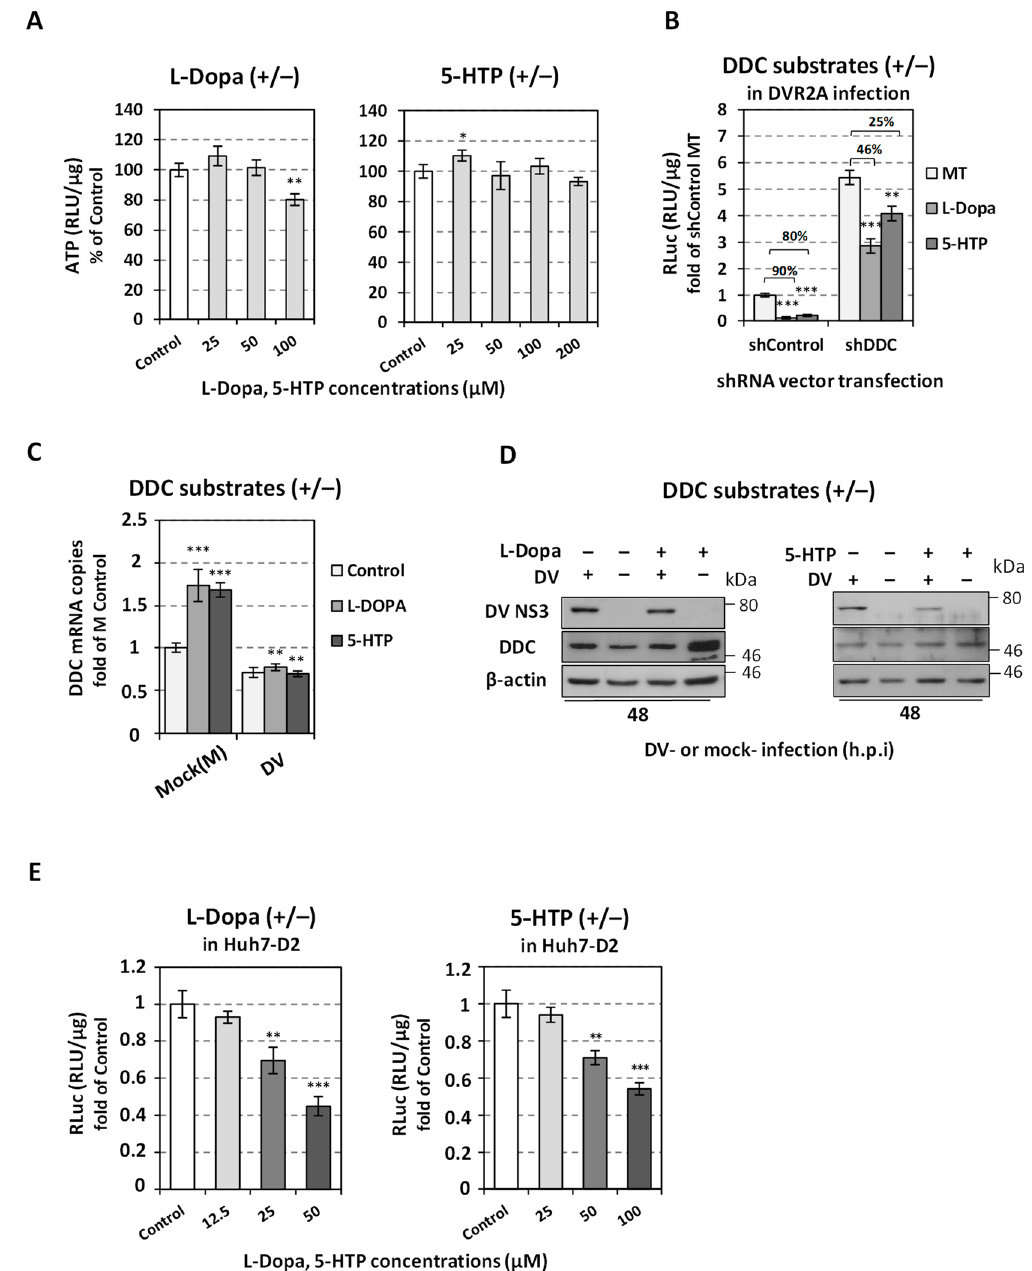
Figure 4. The application of DDC substrates negatively affects the replication of DV. ( A ) Evaluation of different concentrations of DDC substrates concerning their cytotoxicity of DV-infected cells. Huh7 cells were transfected with the shControl vector (via electroporation) and 24 h.p.t. were inoculated with DV (MOI = 0.1) for 4 h. After virus inoculum removal, cells were treated with different concentrations of L-Dopa (left panel) or 5-HTP (right panel), or were mock-treated (Control), for 48 h. Then the cells were lysed and by the use of a chemiluminescence-based assay, the intracellular ATP was quantified. Infected mock-treated cell (Control) values were expressed as one. * p < 0.05, ** p < 0.01 vs. Control ( B ) DDC silencing reduces the effect that the DDC substrates have on DV replication. Huh7 cells were transfected with the shDDC vector or the control vector (shControl). Twenty-four h.p.t., cells were infected with DVR2A (MOI = 0.1) for 4 h and after virus inoculum removal were treated with L-Dopa (50 µ Μ ) or 5-HTP (100 µ Μ ), or were mock-treated (MT), and further cultured for 48 h. Dengue replication-derived Renilla luciferase activity was expressed as RLU/µg of total protein amount. Values are compared to the ones of MT shControl-expressing DVR2A-infected cells. Percentage values over the brackets represent the fold difference of luciferase